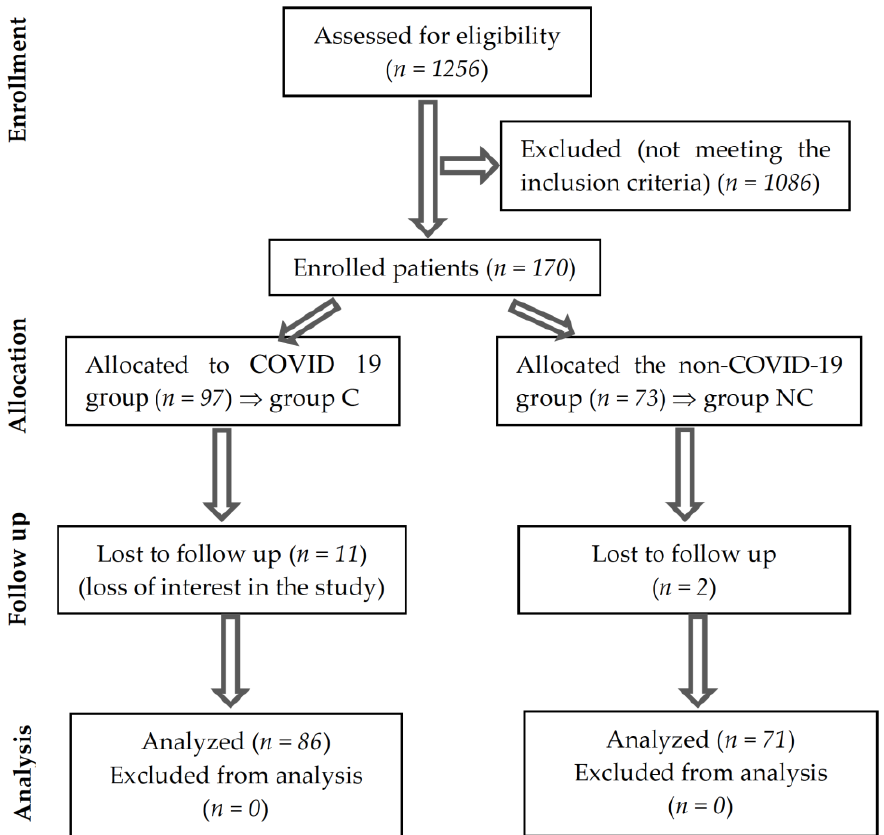
Figure 1. CONSORT flow diagram of the study.